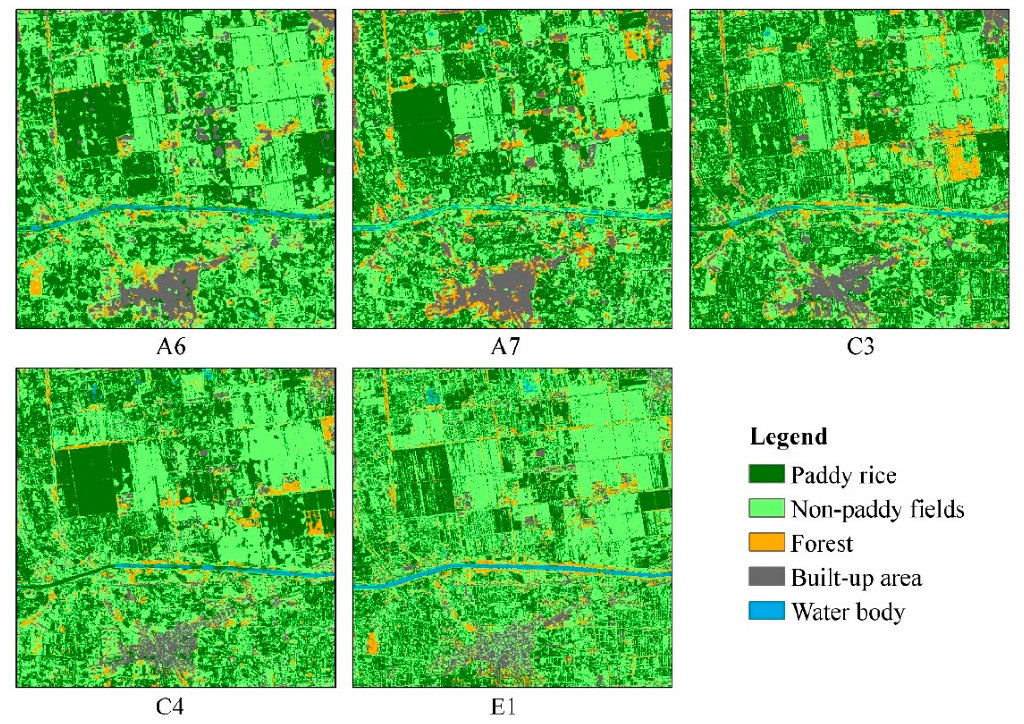
Figure 5. Visualization of combination results with high accuracy.